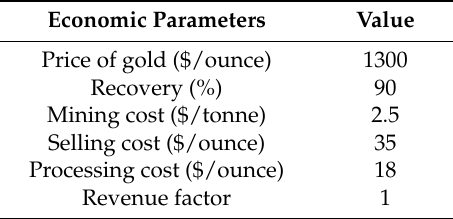
Figure 11. Result of the open‐pit boundary analysis. ( a ) Optimum boundary showing the lower and upper zones (denoted Pit 1 and Pit 2). ( b ) Result of designing the bench, waste dump, and stockpile. Table 2. Economic parameters and values for calculating the economic value of a